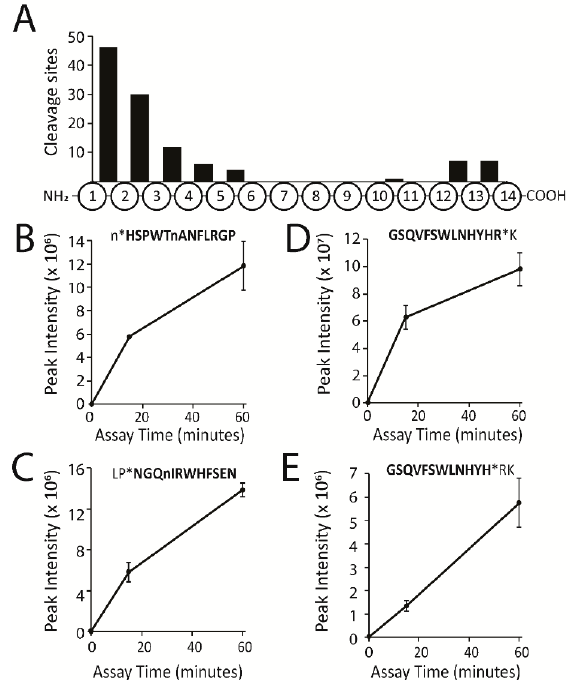
Figure 2. Distribution and quantitation of the cleavage sites within the tetradecapeptide library. ( A ) Distribution of cleavage sites for peptide products that increased by eight-fold or higher after 60 min incubation with p -value < 0.05. ( B ) Quantitation of a representative mono-aminopeptidase cleavage product in the control samples (0 min) and following 15 and 60 min incubations. Assays were performed in triplicate. The quantified peptide is highlighted in bold text, lowercase “n” corresponds to norleucine and * is the cleavage site. ( C ) Quantitation of a representative di-aminopeptidase cleavage. ( D ) Quantitation of a representative mono-carboxypeptidase cleavage product. ( E ) Quantitation of a representative di-carboxypeptidase cleavage